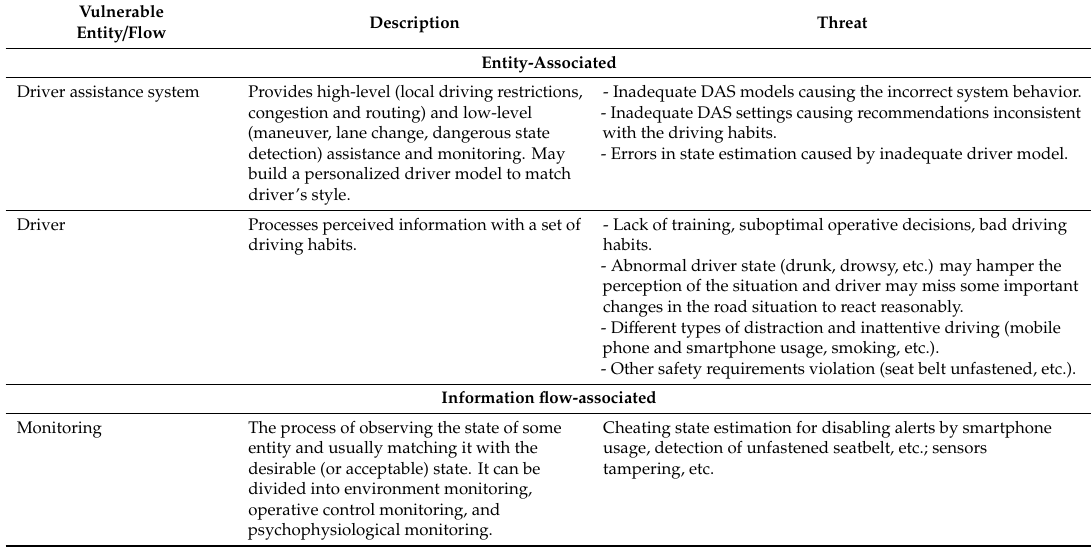
Table 1. Vulnerability classification for driver monitoring